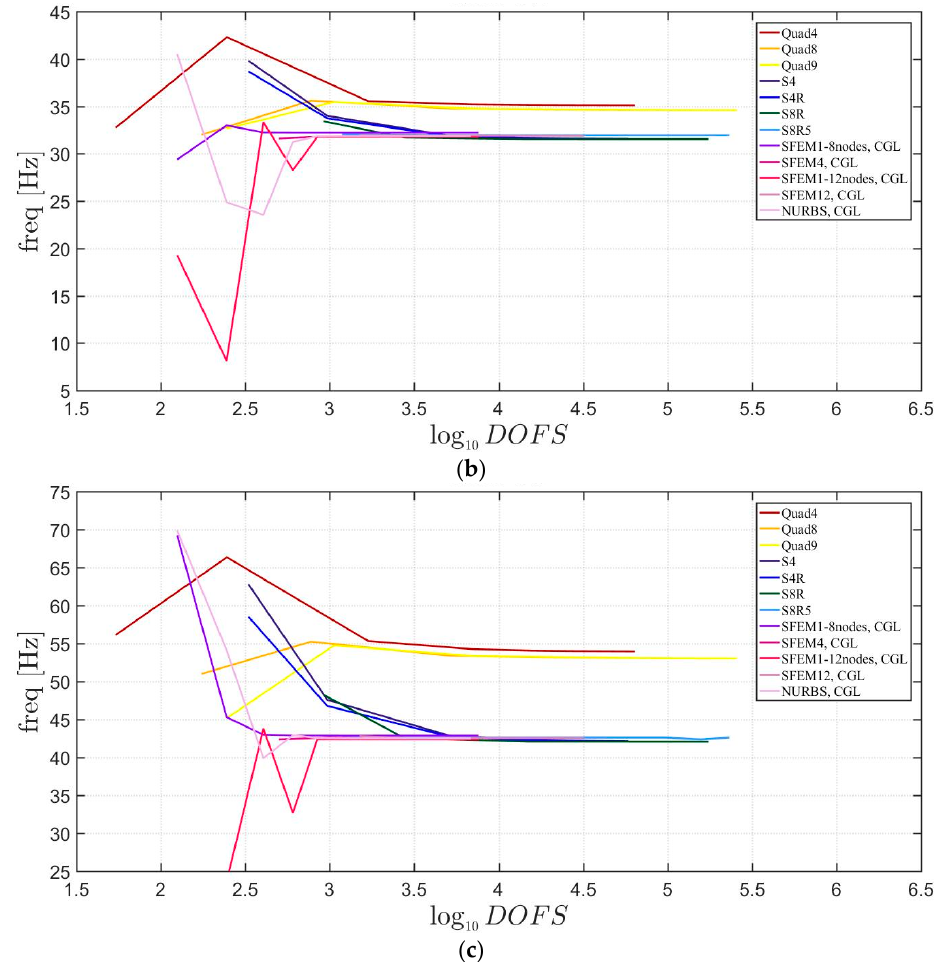
Figure 20. First three natural frequencies of a circular plate with a not-symmetric lamination scheme and a / h = 100: ( a ) First frequency; ( b ) Second frequency; ( c ) Third frequency.